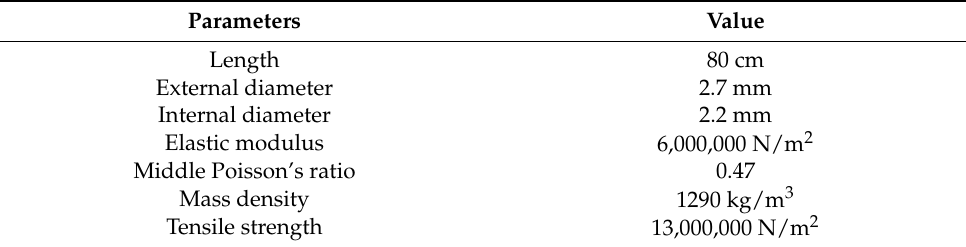
Table 2. Specific parameters of catheter